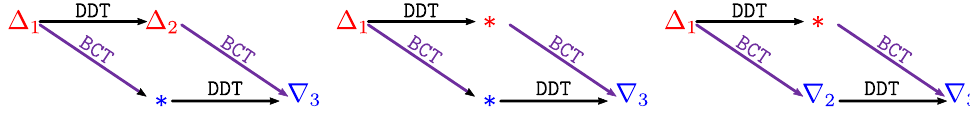
Figure 3: Differences of DBCT ‘ (left), DBCT (middle) and DBCT a